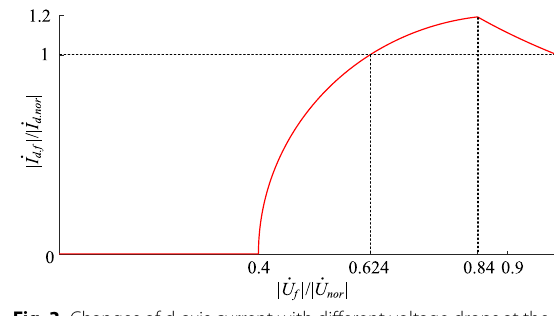
Fig. 3 Changes of d-axis current with different voltage drops at the PCC